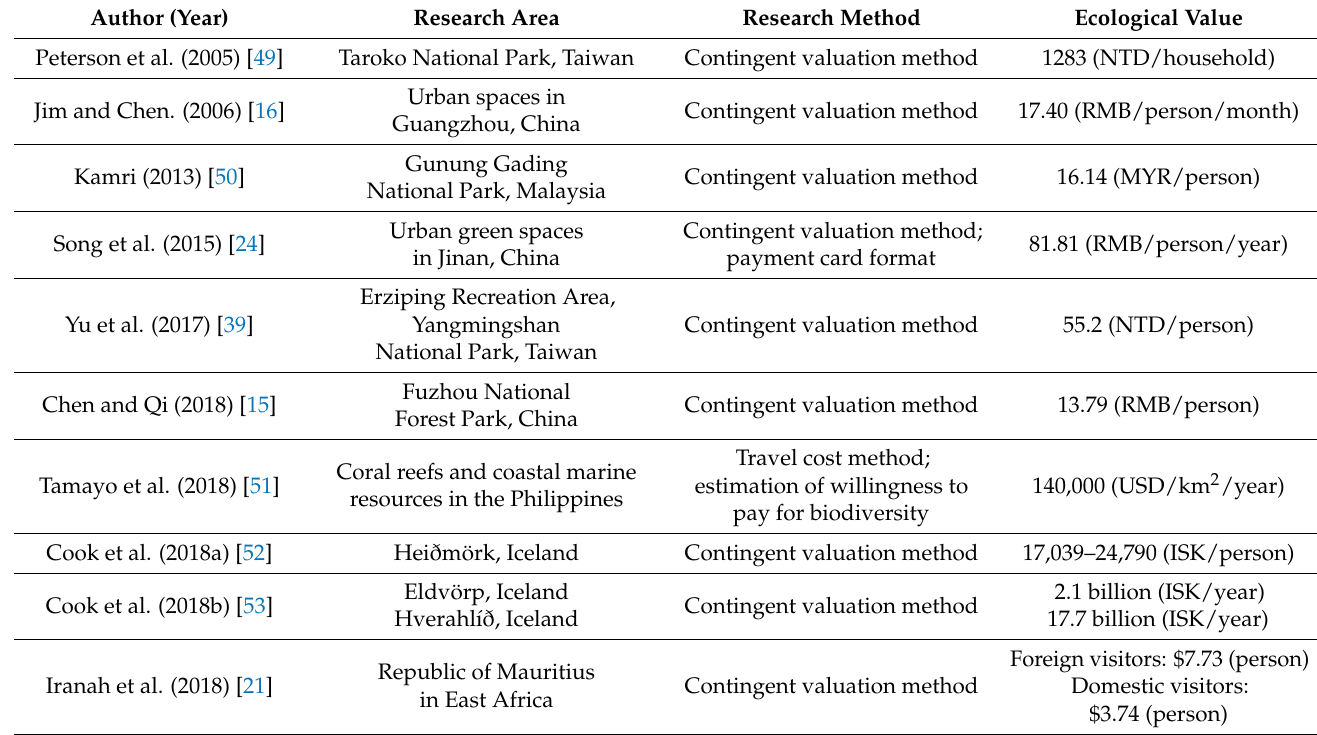
Table 7. Studies on ecological